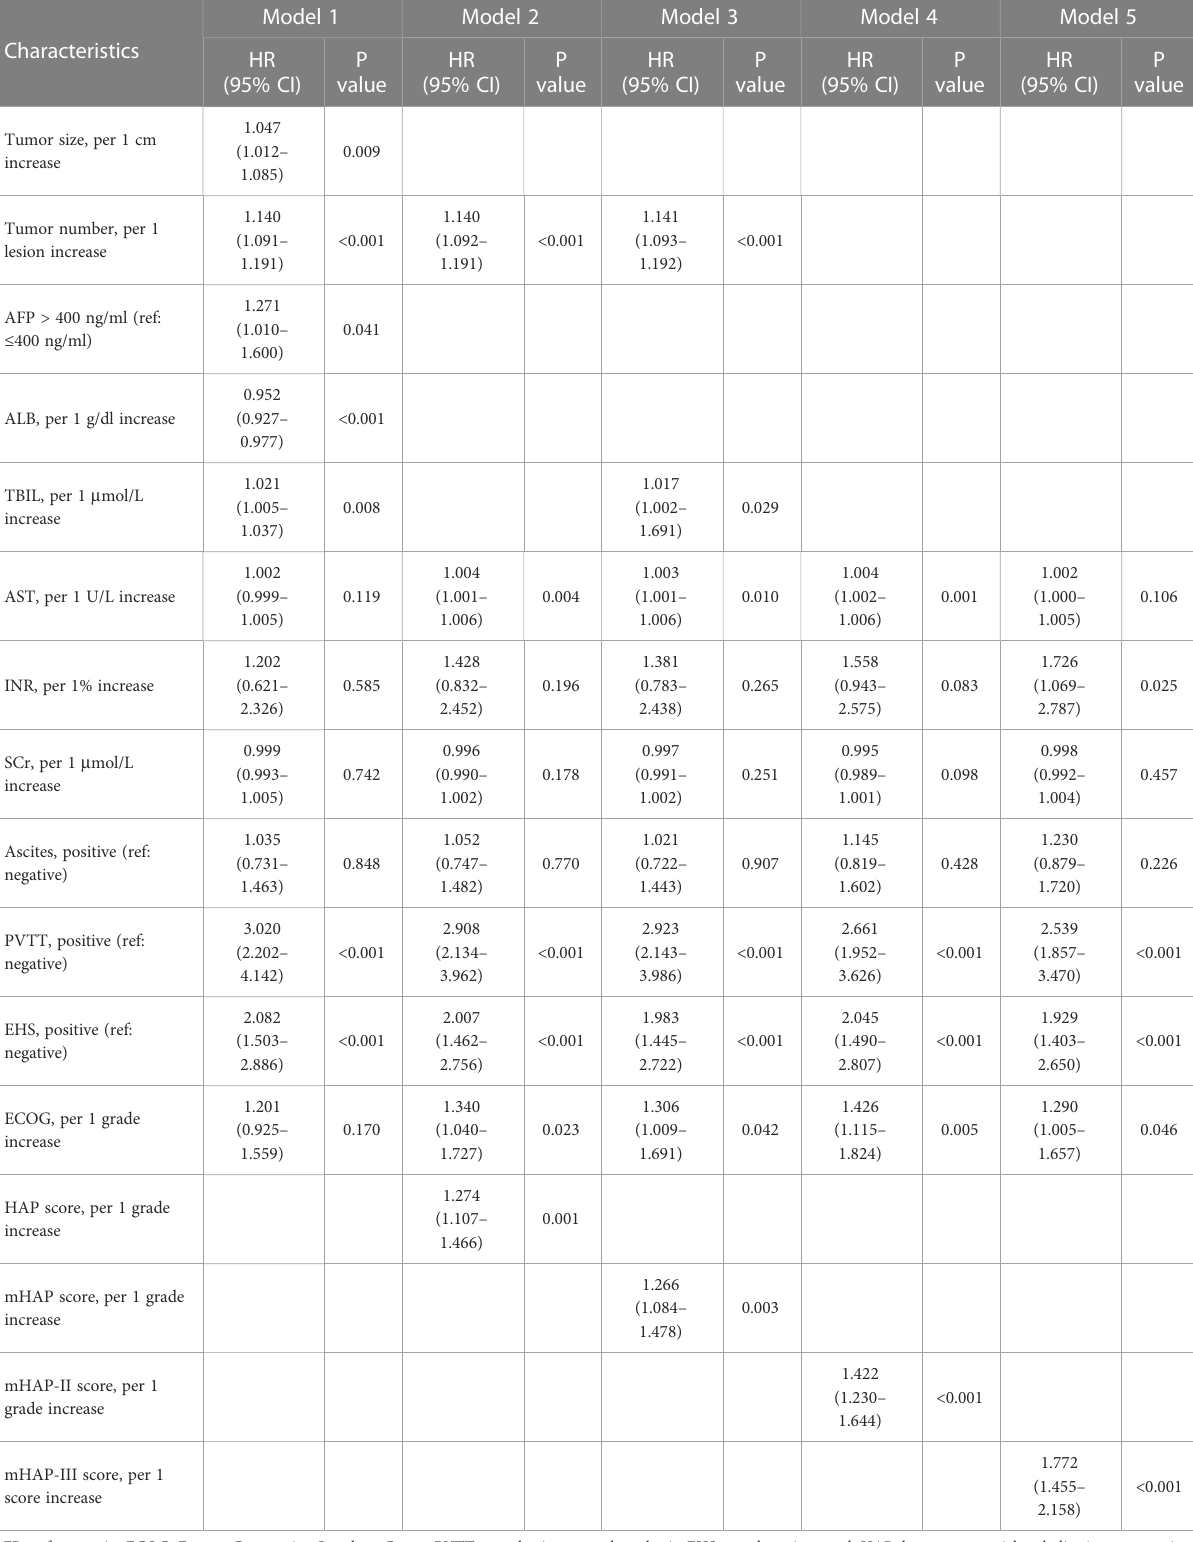
TABLE 4 Multivariate analyses for OS in the whole